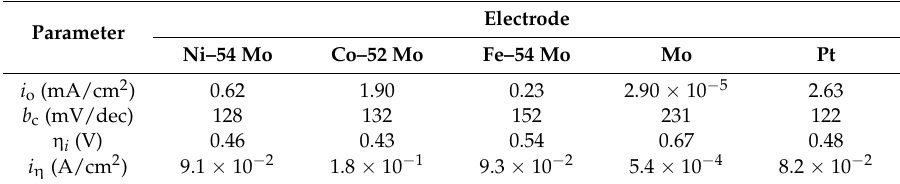
Figure 3. Cathodic polarization curves of ( a ) Mo-rich electrodeposits in 30 wt.% KOH at 25°C and ( b ) plots in semi-logarithmic coordinates. The scan rate was 2 mV/s (composition is given in at.%). Table 3. Calculated apparent exchange current densities ( i 0 ), Tafel slopes ( b c ), overpotentials ( η i ) at i = 0.3 A/cm 2 and current densities ( i η ) at η = − 0.3 V for hydrogen evolution different electrodes (composition is given in at.%). Parameter